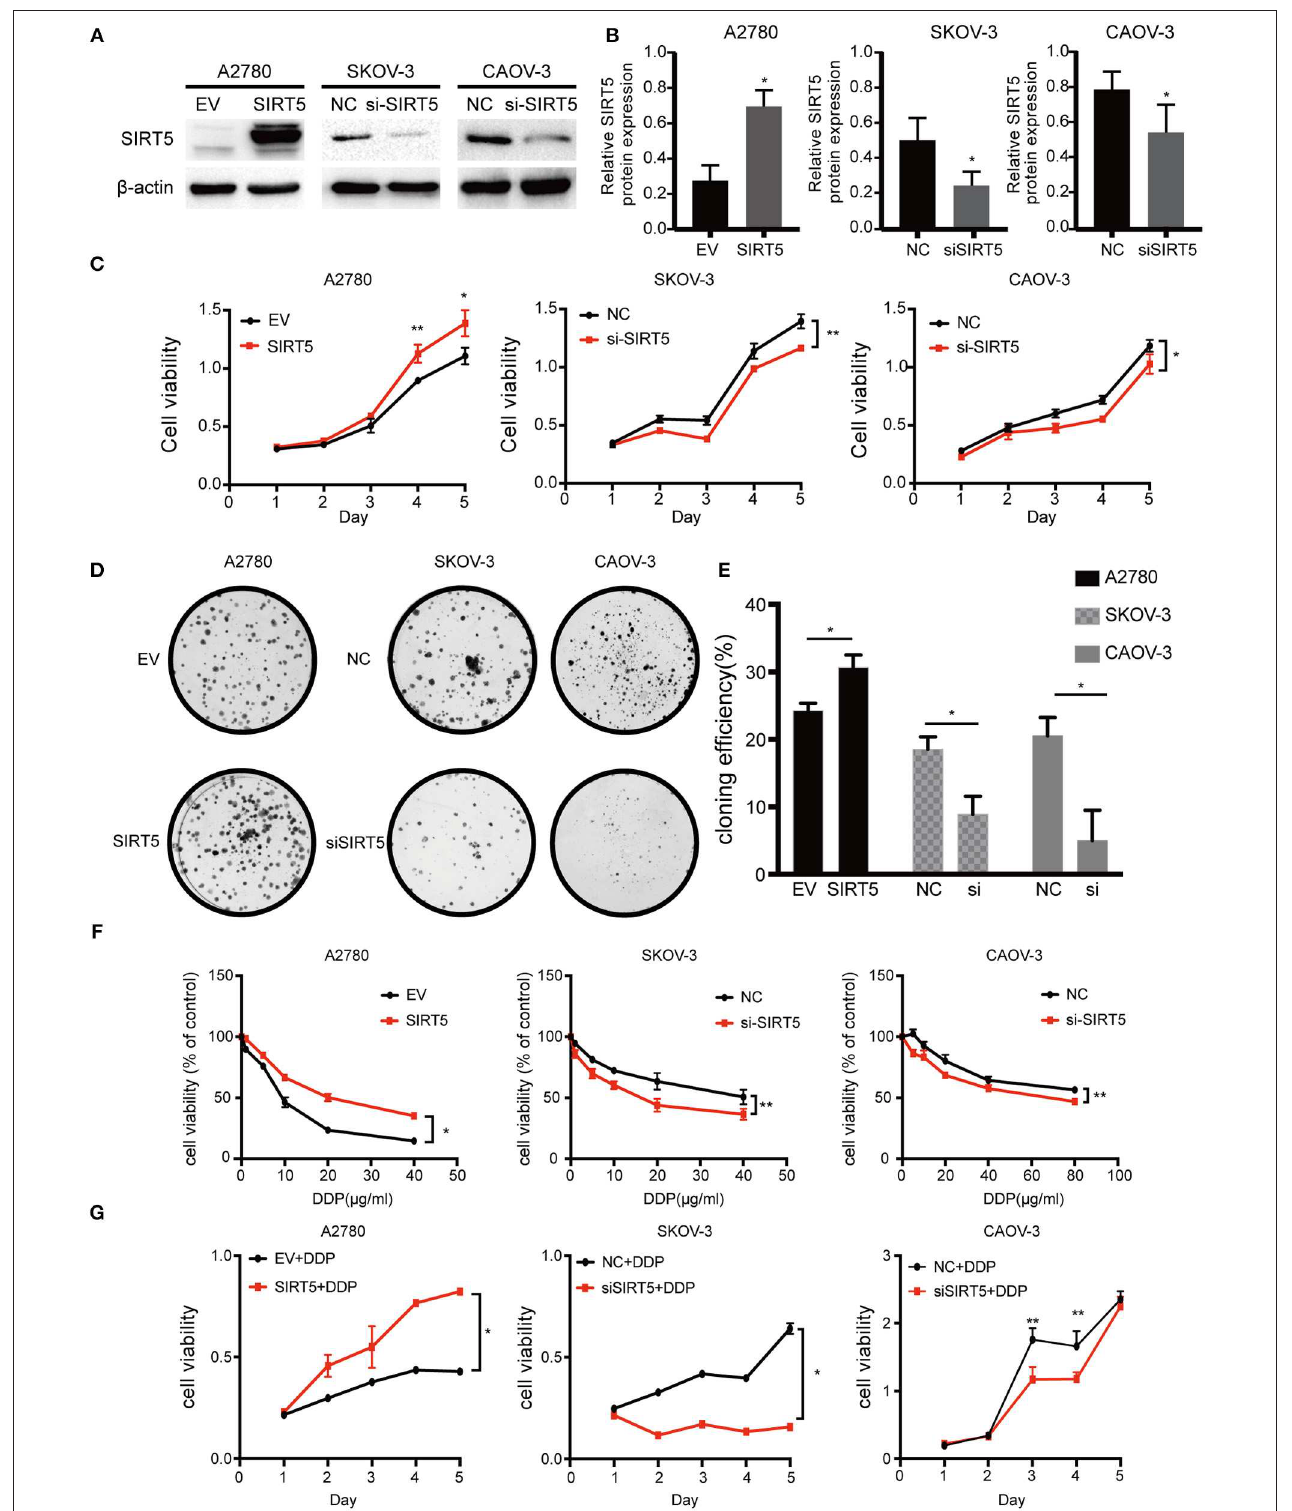
FIGURE 3 | SIRT5 promotes cell proliferation and cisplatin resistance in ovarian cancer cells. (A) A2780 cell lines were transfected with SIRT5 plasmid and SKOV-3 and CAOV-3 cell lines were transfected with SIRT5-siRNA. The transfection efficiency was detected by western blot and (B) the relative gray values were shown in histogram. (C) Overexpression of SIRT5 in A2780 cells promoted cell growth and knockdown of SIRT5 inhibited cell growth in SKOV-3 and CAOV-3 cells. After